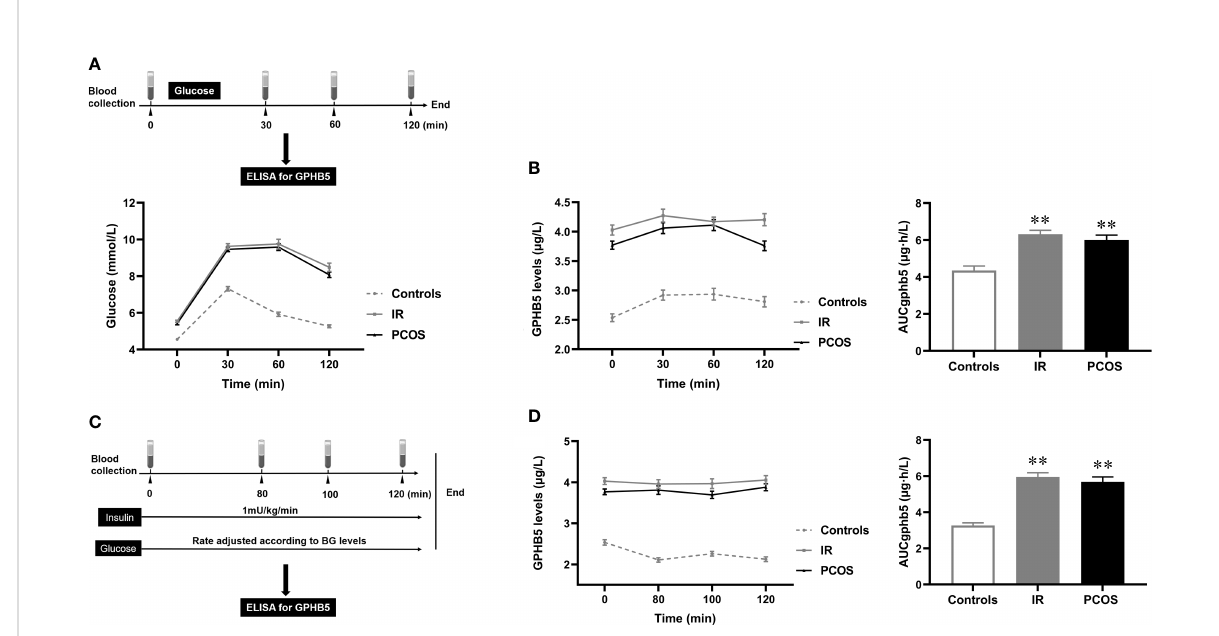
FIGURE 7 Circulating GPHB5 concentration in interventional studies. (A) Experimental procedure for the OGTT and blood glucose during the OGTT. (B) GPHB5 concentration and AUC GPHB5 during the OGTT. (C) Experimental design for the EHC. (D) GPHB5 concentration and AUC GPHB5 during the EHC. Data are means ± SD. ** p < 0.01 vs. controls.